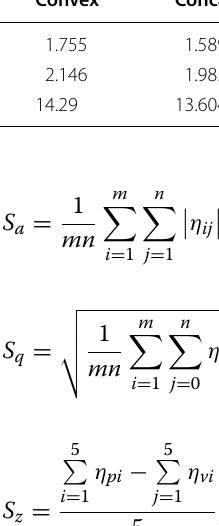
260 m/min) = Convex Concave Convex Concave Convex Concave